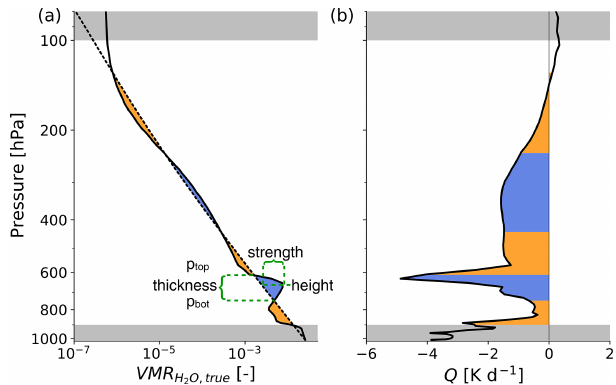
Figure 3. Humidity profile (a) of an atmospheric case with a strong EML and the associated net heating rate (longwave + shortwave) profile (b) . The reference humidity profile used to identify humid- ity anomalies is depicted as the dashed line in (a) . Layers of moist anomalies are highlighted by blue shading, dry anomalies by or- ange shading. Anomalies that intersect with the grey-shaded re- gions are excluded to restrict anomalies to the free troposphere. The green lines and brackets conceptually display the definition of mois- ture anomaly characteristics from Table 1 for the strong positive anomaly at around